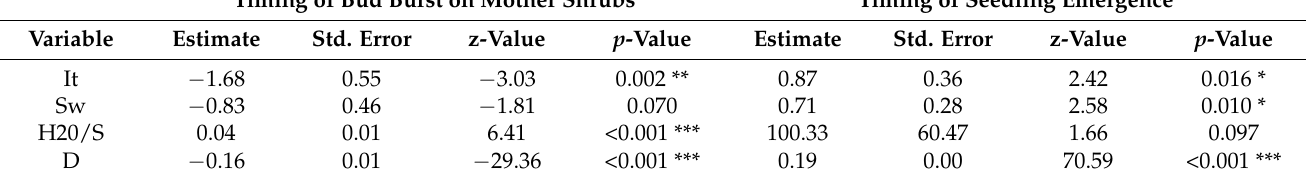
Table 6. Statistical analysis of the timing of bud burst on the mother shrubs and the timing of seedling Figure 5. Modelled timing of seedling emergence in the spring of 2021, according to the day of berry emergence, both in the spring of 2021. In the model, the Belgian provenance is the standard to which collection in 2020 ( a ) and the provenance and mean stone weight ( b ). the Italian (It) and Swedish (Sw) provenances are compared.